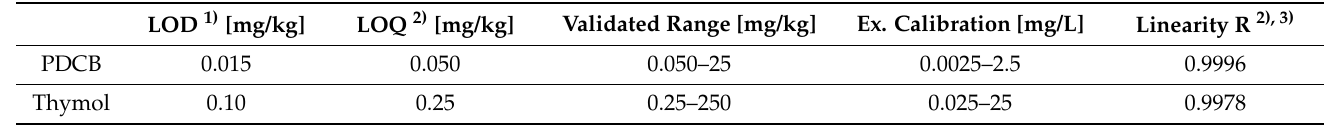
Table 1. Detection and quantitation limits, and the validated range for quantitation of PDCB and thymol in beeswax using DHS-VTT-GC-MS